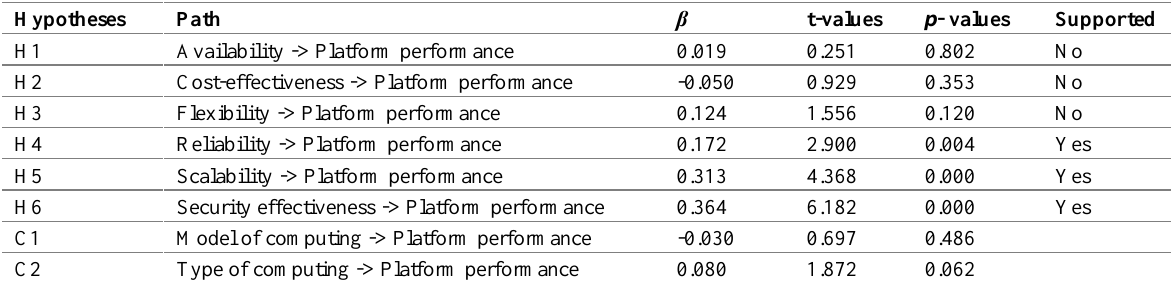
Table 6: Path Coefficient